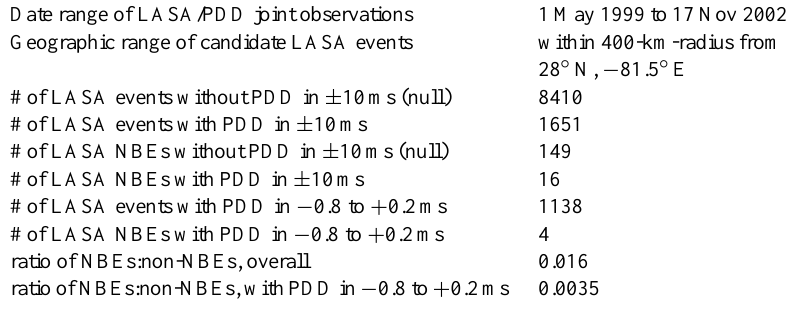
Table 1. LASA/PDD joint observations within 400km radius of array center. Date range of LASA/PDD joint observations